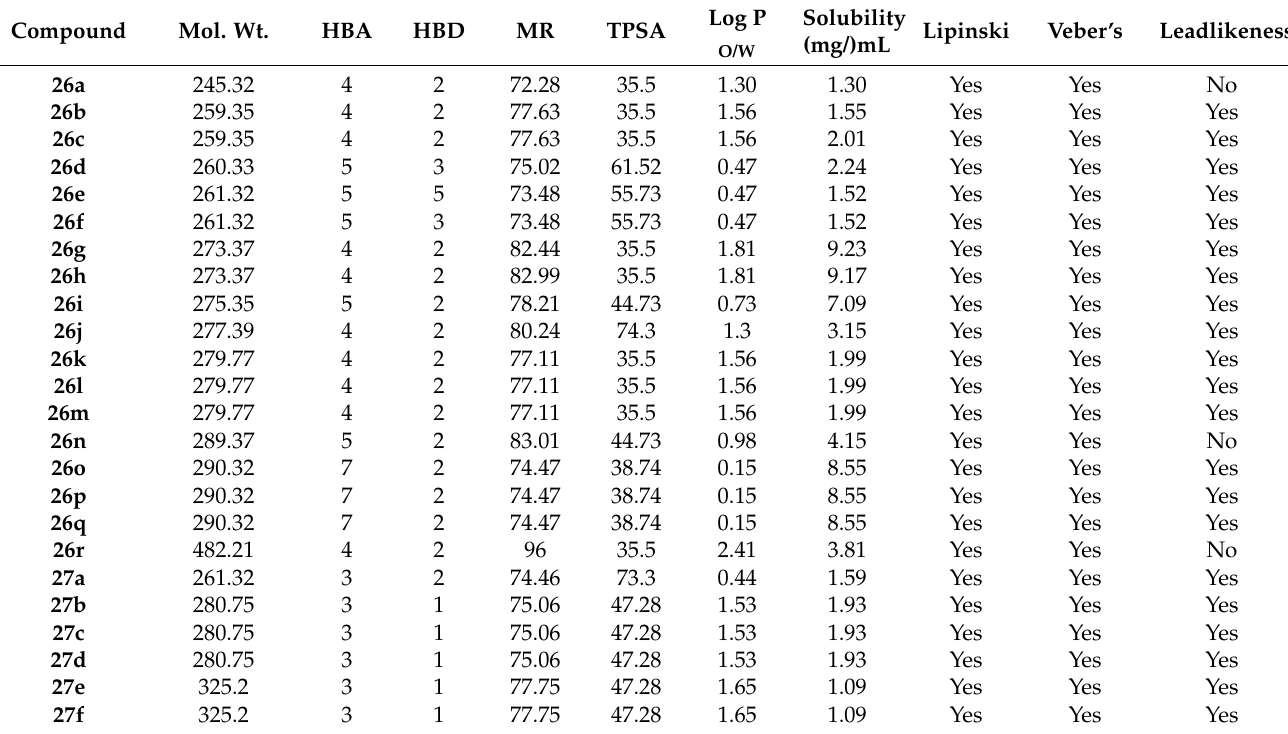
Table 4. Predictive ADME studies of the designed